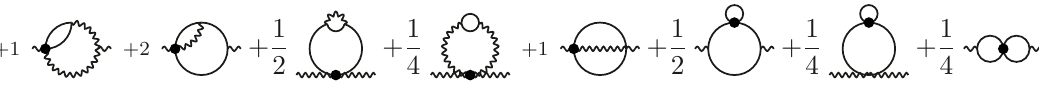
Figure 5 . 2-loop contributions to the 2-point function, originating from 4-point Chapman vertices (the notation is as in figure 3).